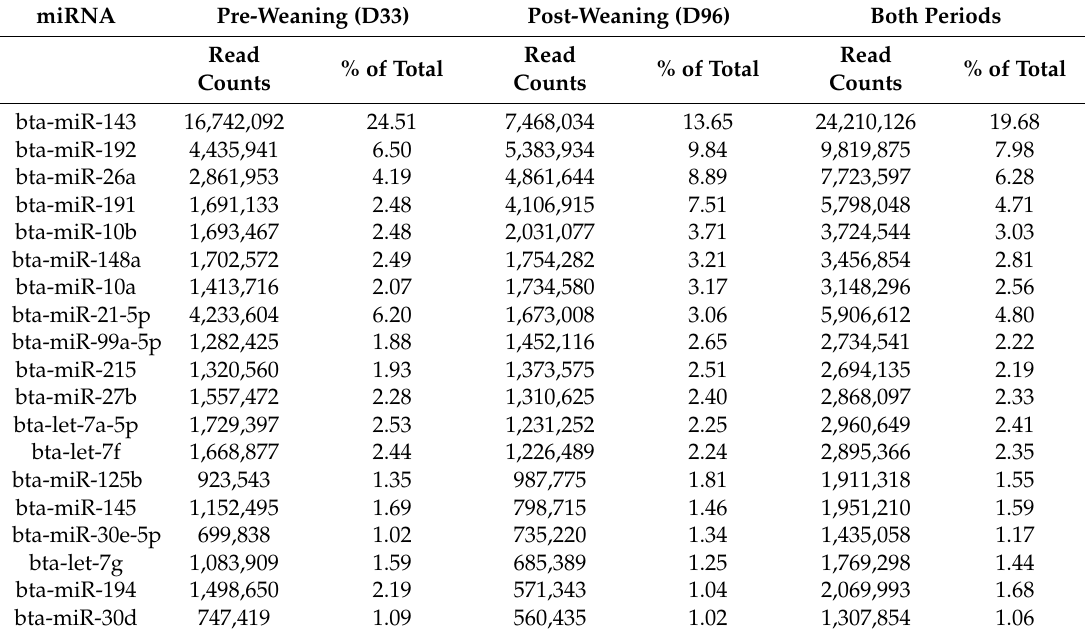
Table 1. The 20 most abundantly expressed miRNAs in ileum tissue of calves. miRNA Pre-Weaning (D33) Post-Weaning (D96) Both